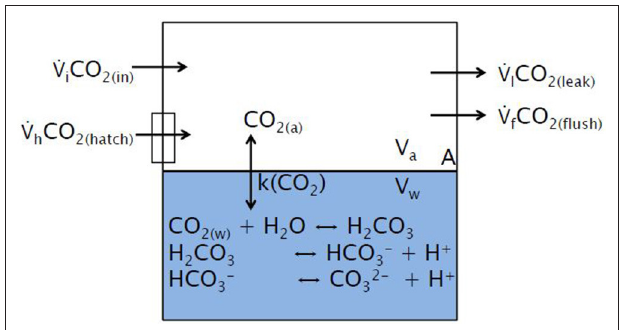
FIGURE 1 | Conceptual model for the air-side and water-side of the system. The following naming convention was used: A: water surface area; V a : air volume; V w : water volume; k(CO 2 ): total gas transfer velocity; CO 2(a) : CO 2 air concentration; CO 2(w) : CO 2 water concentration; CO 2(in) : CO 2 concentration in the ambient air/lab; CO 2(hatch) : CO 2 concentration when the Aeolotron hatch was open; CO 2(leak) and CO 2(flush) : CO 2 concentrations in the air that leaked and in the air that is being flushed in the Aeolotron. Reaction of CO 2 in the surface water is also shown; a and w stand for air and water,